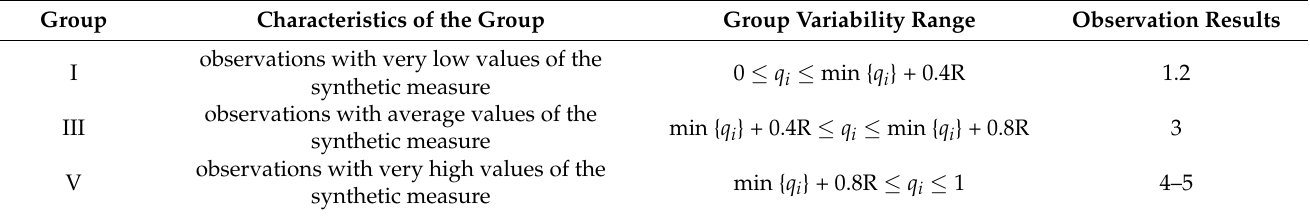
Table 10. Characteristics of the classification of observations according to the value of the synthetic measure of GHG emission, depending on the type of fertilization used in the cultivation of beans. Group Characteristics of the Group Group Variability Range Observation Results observations with very low values of the I observations with average values of